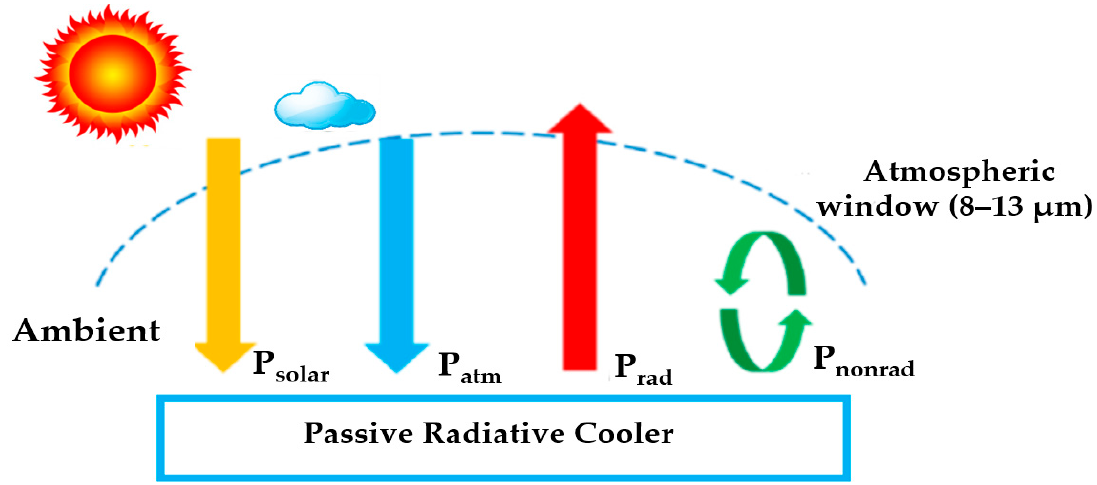
Figure 4. Schematic representation of radiative cooling surface (adapted from [42]).